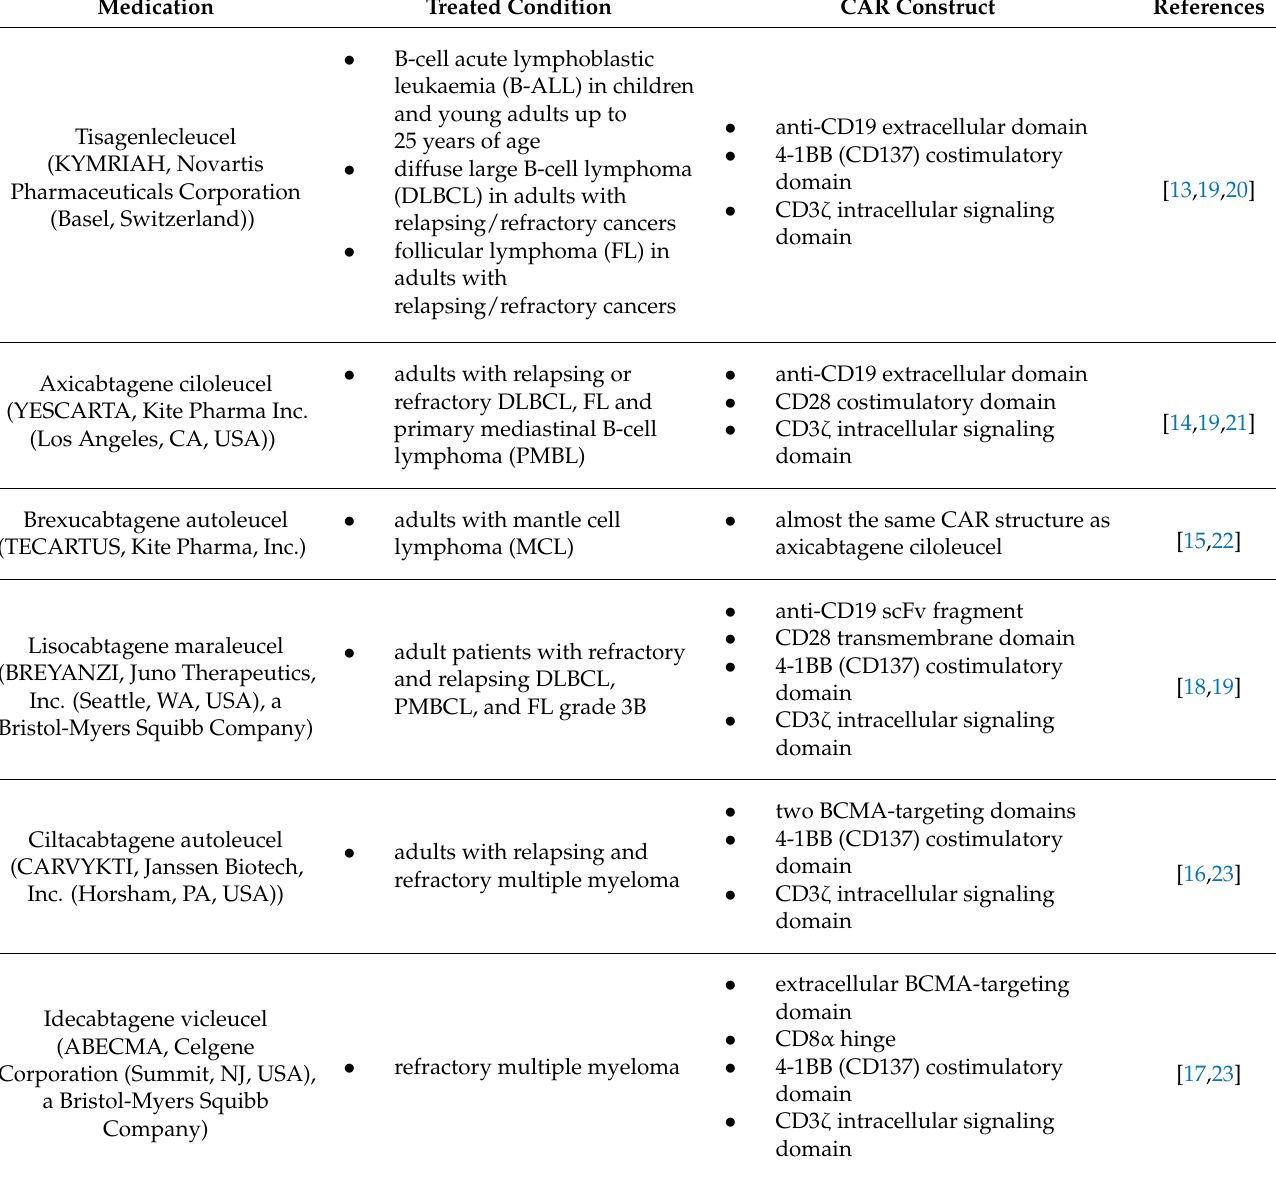
Table 1. CAR-T cells approved for clinical practice in the European